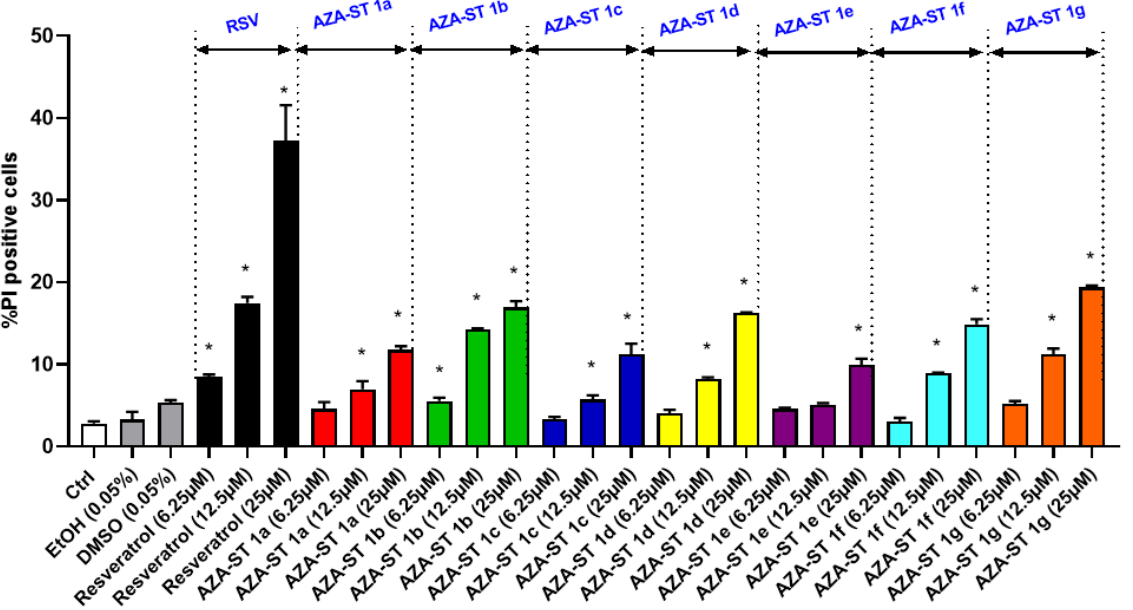
Figure 4. Flow cytometric evaluation of the effects of AZA-ST 1a–g and resveratrol on plasma mem- brane damages and cell viability by staining with propidium iodide (PI). N2a cells were incubated for 24 h with or without AZA-ST 1a–g or resveratrol ( trans -resveratrol) at concentrations in the range of the IC50s (6.25, 12.5 and 25 µM). The data are the mean ± standard deviation (SD) of three independent experiments performed in triplicate. The comparison of the data was performed with an ANOVA test followed by a Bonferroni test. (*): p ≤ 0.05 was considered statistically significant. Vehicles (Ethanol (EtOH) for RSV; DMSO for AZA-ST) [15]: EtOH (0.05%) and DMSO (0.05%); the highest concentrations of vehicles were only analyzed.